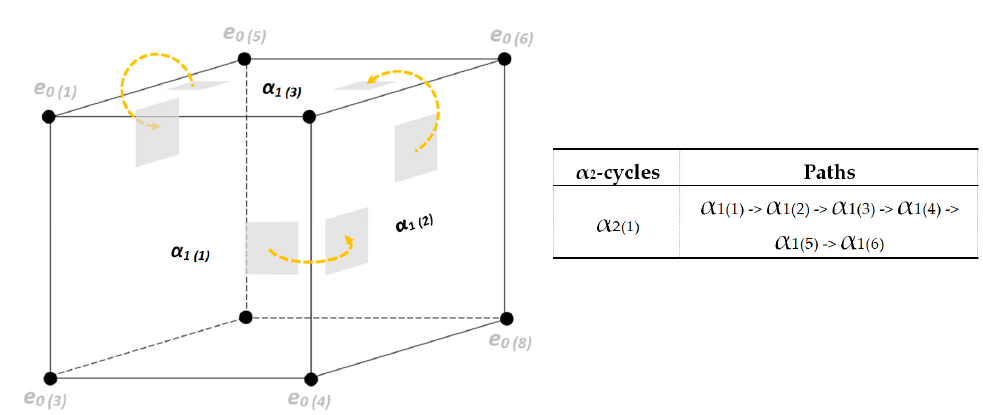
Figure 2. α 1 -cycles and their connectivity Figure 2: α 1 -cycles and their connectivity